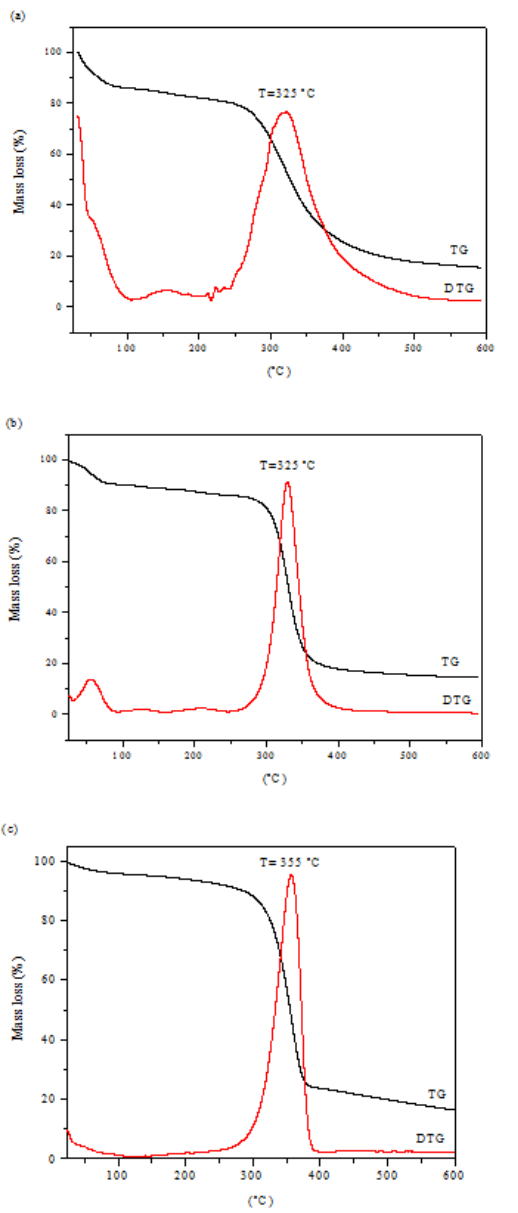
Figure 2. TG curves (----) and DTG (-----): (a) pure collagen, (b) BC/COL hydrogel and (c) pristine BC.